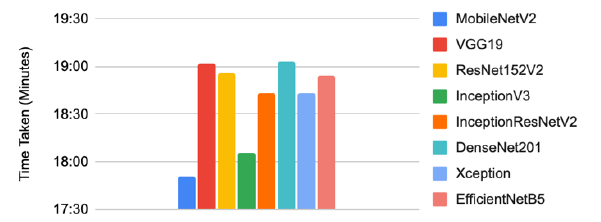
Figure 4: Training time for scene classification models